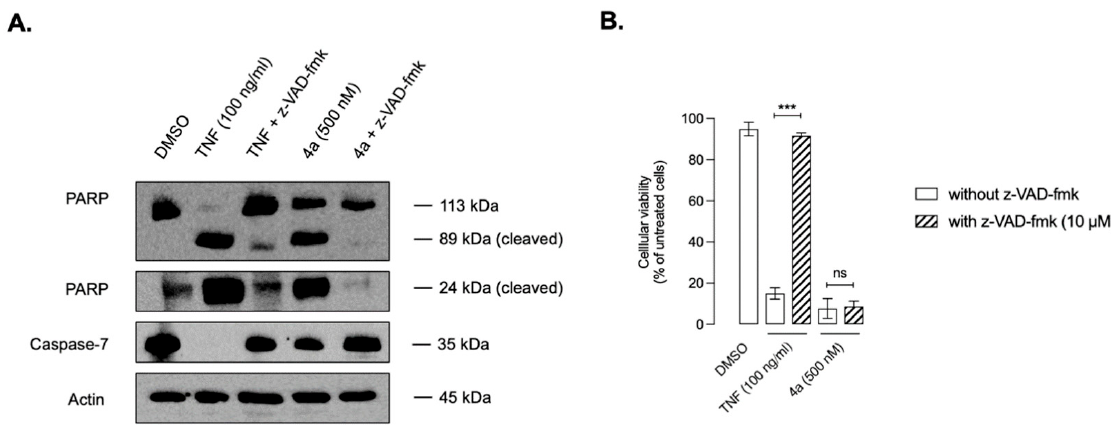
Figure 14. Evaluation of apoptotic biomarkers. MCF7/FasR cells were irradiated at 458 nm with 500 nM of complex 4a or 100 n/mL TNF α for 72 h in presence or not of 10 µ M z-VAD-fmk. ( A ) Cytosolic extracts from MCF7/FasR cells were separated by SDS-PAGE and probed with full-length and p24 cleaved anti-PARP and anti-caspase-7. Migrations indicated are: full-length PARP p113, cleaved PARP p89, cleaved PARP p24 and full-length caspase-7. ( B ) Cell viability was evaluated in duplicate samples. Data are expressed as percent (%) of untreated cells and are the means of 3 independent experiments (***, p < 0.0001, NS, not significant).